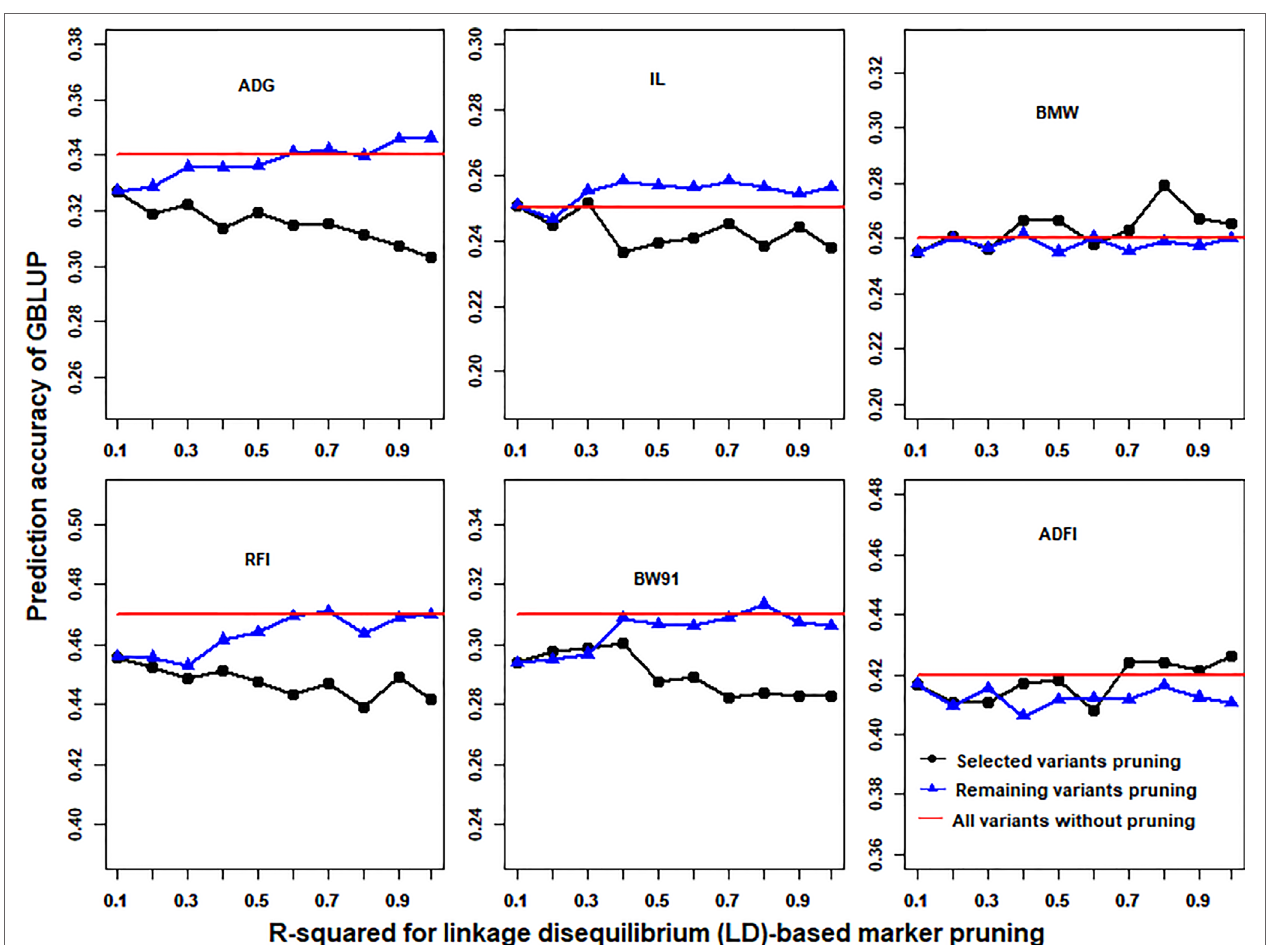
FIGURE 4 | Impact of the linkage disequilibrium (LD)-based marker pruning of selected or remaining variants on prediction accuracy. R-squared of LD less than 0.1 was fixed to prune selected (or remaining) variants, and then the remaining (or selected) variants that were pruned with different R-squared cutoffs of LD (0.99, 0.9, 0.8, 0.7, 0.6, 0.5, 0.4, 0.3, 0.2, and 0.1) for GBLUP were merged. The red line is the prediction accuracy of GBLUP with all markers of imputed WGS data. The predictive ability was assessed by the Pearson correlation between the predicted genetic values and the observed phenotypes corrected for fixed effect(s) per trait. These traits were average daily gain (ADG), intestine length (IL), breast muscle weight (BMW), residual feed intake (RFI), body weight in 91 days (BW91), and average daily feed intake